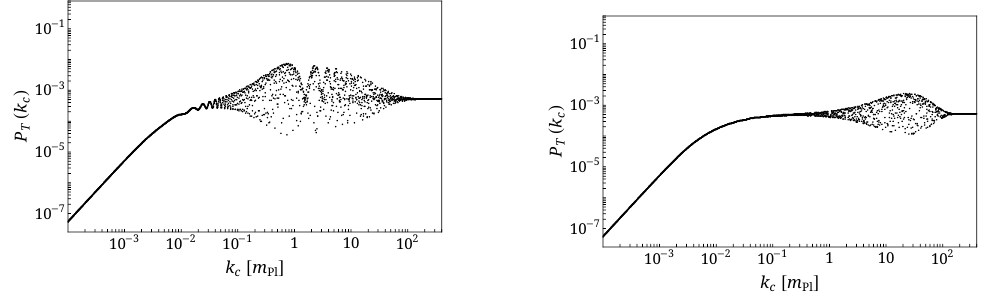
Figure 8. ( First panel ) Evolution of the scale factor with C = 1, µ = − 400, σ = 2. but different values of B . ( Second panel ) Associated tensor potentials around the bounce.